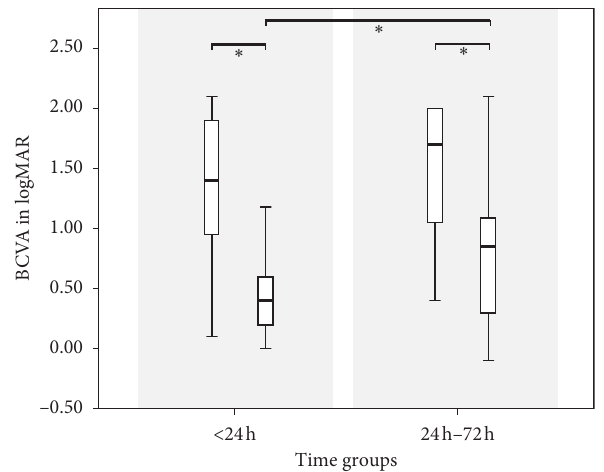
Figure 1: The best-corrected visual acuity (BCVA) of the fovea- involving primary rhegmatogenous retinal detachment at baseline and at follow-up examination, after surgical reattachment cate- gorized into time groups. There was a significant increase in BCVA after surgery in both groups and a significantly better outcome in patients receiving surgery within 24h compared to those receiving surgery 24h to 72h after